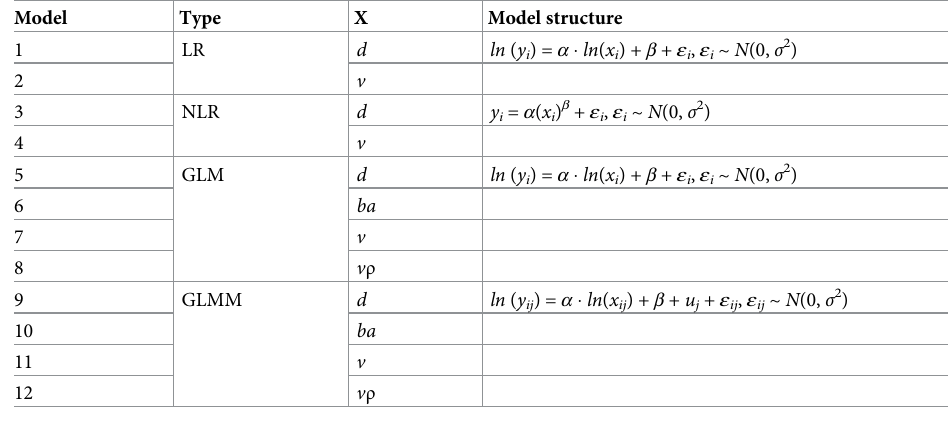
LR = linear regression, NLR = nonlinear regression, GLM = generalized linear model, GLMM = generalized linear mixed-effect model, d = diameter (cm), ba = basal area (cm 2 ), v = volume (dm 3 ), v ρ = volume (dm 3 ) (cid:1) species wood density (g dm -3 ), y = aboveground biomass (g) of tree i , x = explanatory variable of tree i , ε = error associated with i i i tree i , y ij = aboveground biomass (g|) of tree i from species j , x ij = explanatory variable of tree i from species j , u j = random-effect parameter generated by species effect, and ε ij = error associated with tree i from species j .